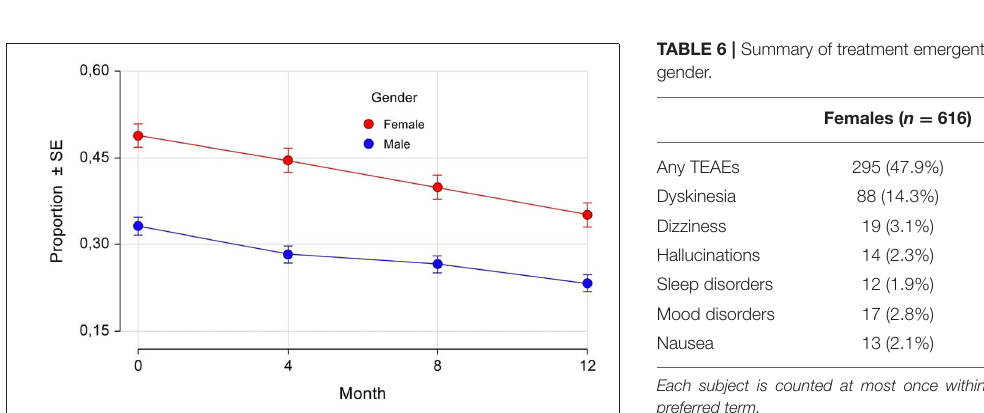
dyskinesia in both genders, with a rapid-onset effect that may be explained by glutamate modulation. Glutamate and other neurotransmitters, in addition to dopamine, are known to contribute to the appearance of motor complications (28).